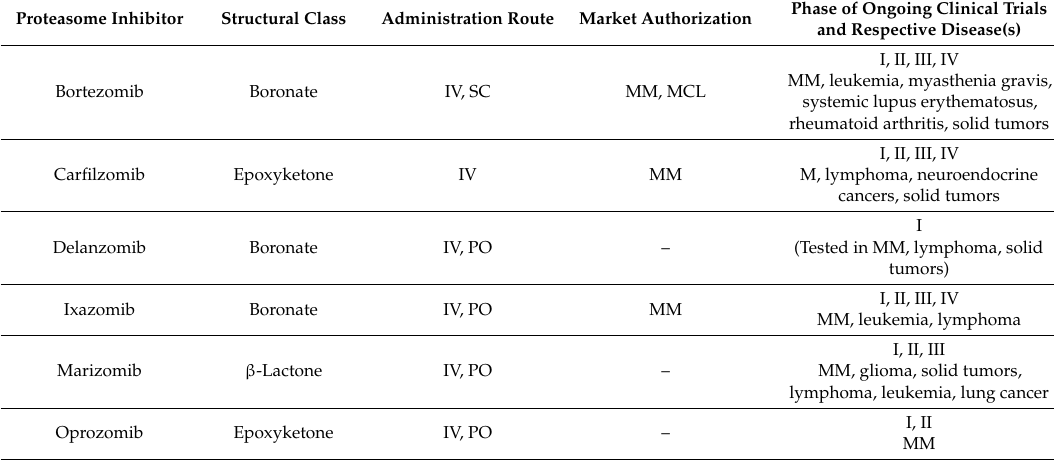
Table 1. Inhibitors of the human 20S proteasome on market and submitted to clinical trials. The corresponding structures and activities can be found in Figure